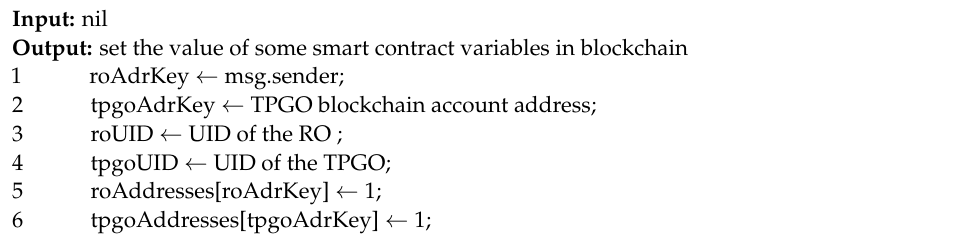
Algorithm 1: Algorithm to set smart contract variables from constructor